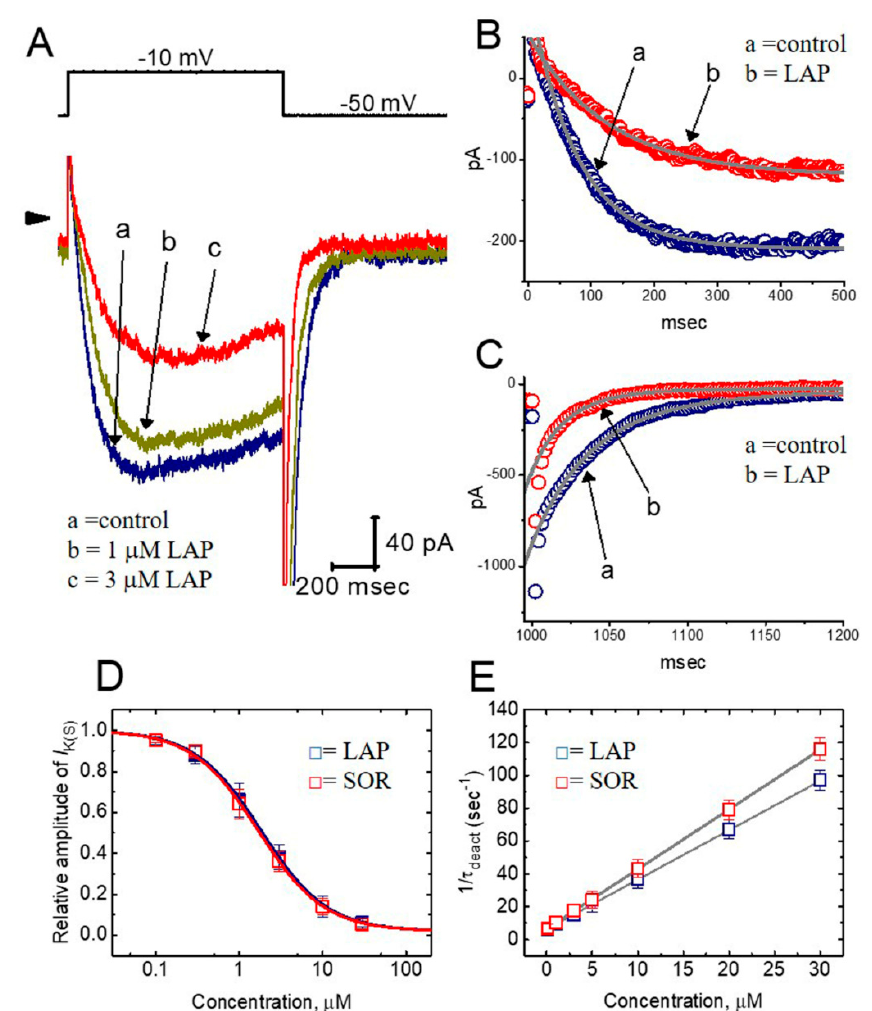
Figure 2. Effect of lapatinib (LAP) or sorafenib (SOR) on the slowly activating delayed-rectifier K + current ( I K(S) ) recorded from H9c2 cells. ( A ) Representative I K(S) traces elicited by a depolarizing pulse from − 50 to − 10 mV (indicated in the upper part of (A)). Label ‘a’ is the control and labels ‘b’ and ‘c’ were obtained 2 min after the addition of 1 and 3 µ M LAP, respectively. Arrowhead indicates the zero current level. In ( B ) and ( C ), labels ‘a’ and ‘b’ indicate the absence and presence of 3 µ M LAP, respectively. The current trajectories shown in (B) were satisfactorily fitted by a single exponential (indicated by the smooth line) with an activation time constant ( τ act ) value of 74.8 msec (a, in the control) and 126.5 msec (b, in the presence of LAP). Those in (C) were fitted by a two-exponential process with the slow and fast deactivation time constant ( τ deact ) values of 90.3 and 35.3 msec (a, in the control) and 60.7 and 31.5 msec (b, in the presence of LAP). ( D ) Concentration-dependent inhibition of I K(S) by LAP or SOR ( n = 8–11 for each point). The relations between the normalized amplitude of I K(S) and the concentration of LAP or SOR are illustrated. The values of IC 50 in the presence of LAP and SOR were 1.84 and 1.69 µ M, respectively. ( E ) Evaluation of the kinetics of a LAP- or SOR-induced block of I K(S) measured from H9c2 cells. The reciprocal in the slow component of τ deact was plotted versus the LAP ( □ , blue) or SOR ( □ , red) concentration ( n = 8–10 for each point).